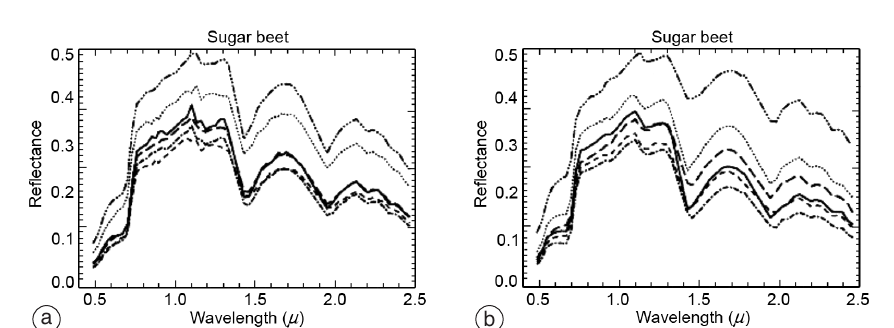
a b Fig. 5a,b. Angular effects in canopy reflectance of sugar beet associated to the six angular configurations con- sidered in fig. 4a: a) measured HyMap data; b) predicted by the model.